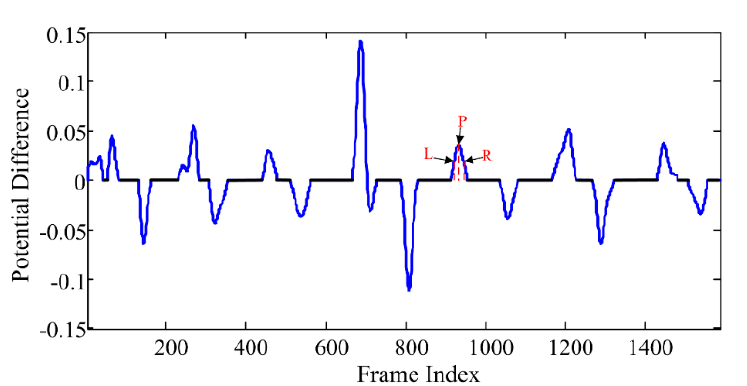
Figure 3. Segmentation result of the action “drinking water” in CAD-60 dataset. The black lines indicate the pose feature segments, and the blue curves indicate the motion feature segments. The L/P/R indicate the left hillside/the peak/the right hillside positions of one curve respectively, which will be used in the atomic motion extraction process in Section 3.3.1.